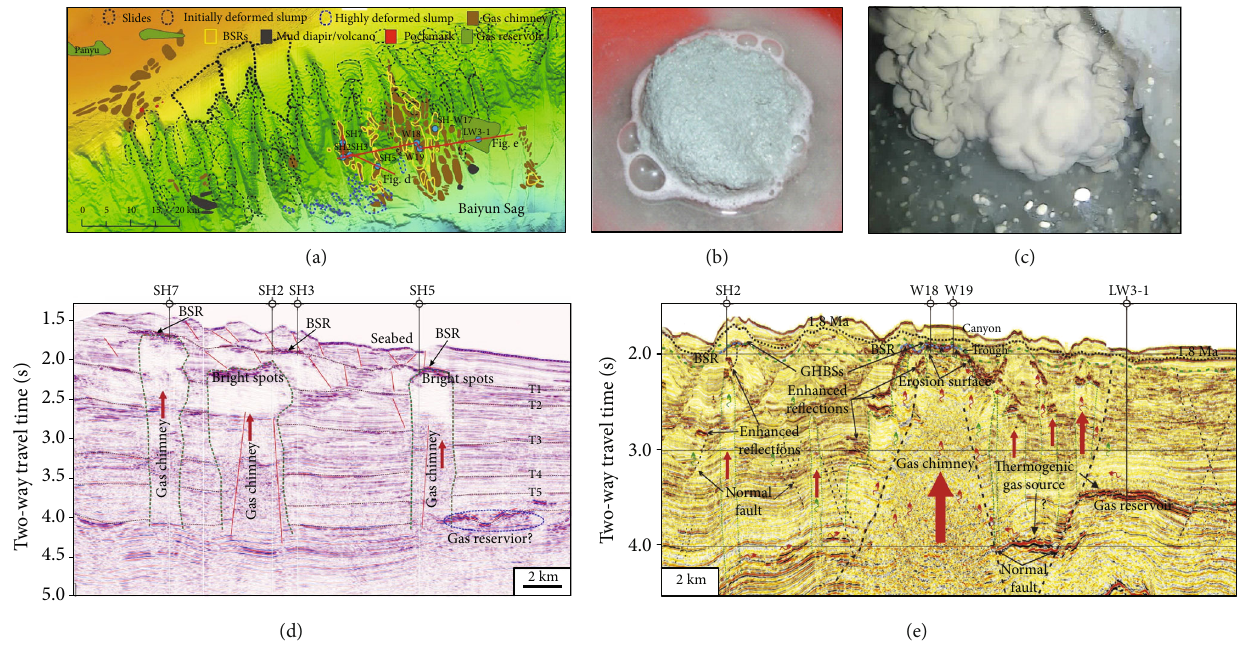
Figure 9: (a) Overlapping relationship between the gas chimneys, mud diapirs, mud volcanos, pockmarks, BSRs, and gas reservoir in the Shenhu area (modi fi ed from Chen et al. [103]). (b) Dissociation of pore- fi lling disseminated gas hydrate sample. (c) Gas hydrate fl oating during deep drilling [81]. (d) and (e) Seismic pro fi les showing the geophysical re fl ection characteristics of the gas hydrate drilling sites in the Shenhu area (modi fi ed from Jin et al.